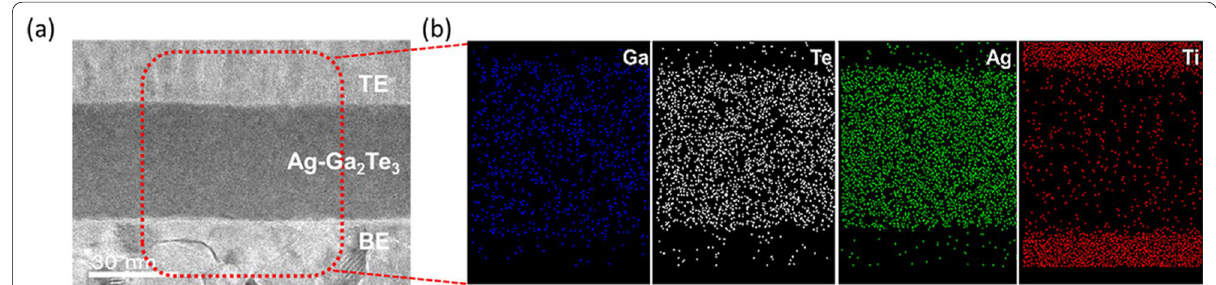
Fig. 2 a Cross-sectional TEM image of the TiN/Ag-Ga 2 Te 3 /TiN device structure. b TEM–EDS mapping images of Ga, Te, Ag, and Ti for the red rectangular region marked in a